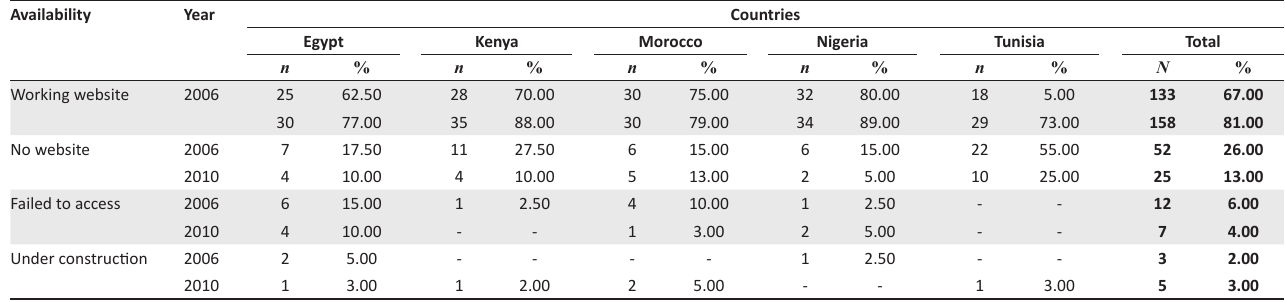
TABLE 1: Availability of corporate websites.